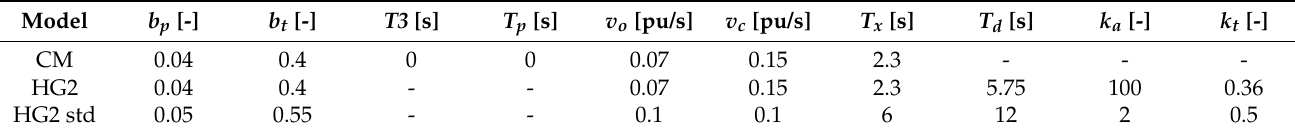
Table 1. Parameters related to different models of the PFC.